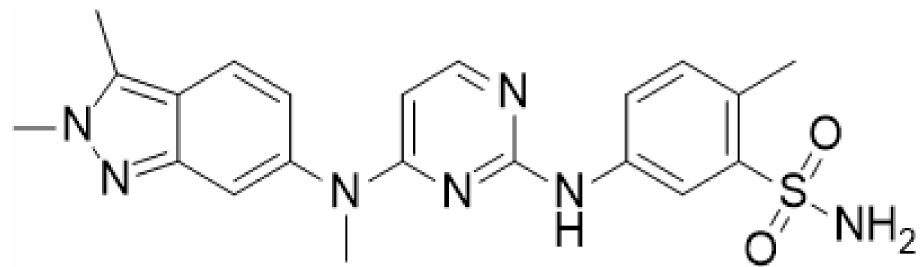
Figure 1. Chemical structure of pazopanib